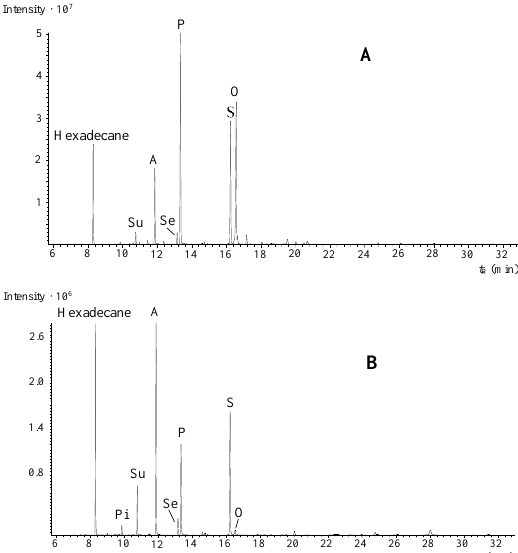
Figure 1. Representative selected ion monitoring (SIM) chromatograms of aged oil paint mock-ups, pigment concentration of 50 g/100 g. ( A ) zinc white and linseed oil and ( B ) Prussian blue and linseed oil. Hexadecane was used as the internal standard, and the abbreviations of other peaks are explained in the text.